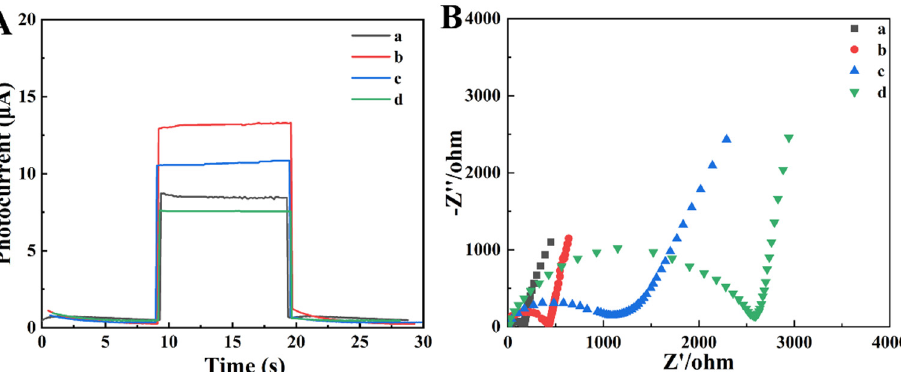
Figure 4. ( A ) Photocurrent responses of the modification of PWE in PBS (0.1 M, pH 7.4)